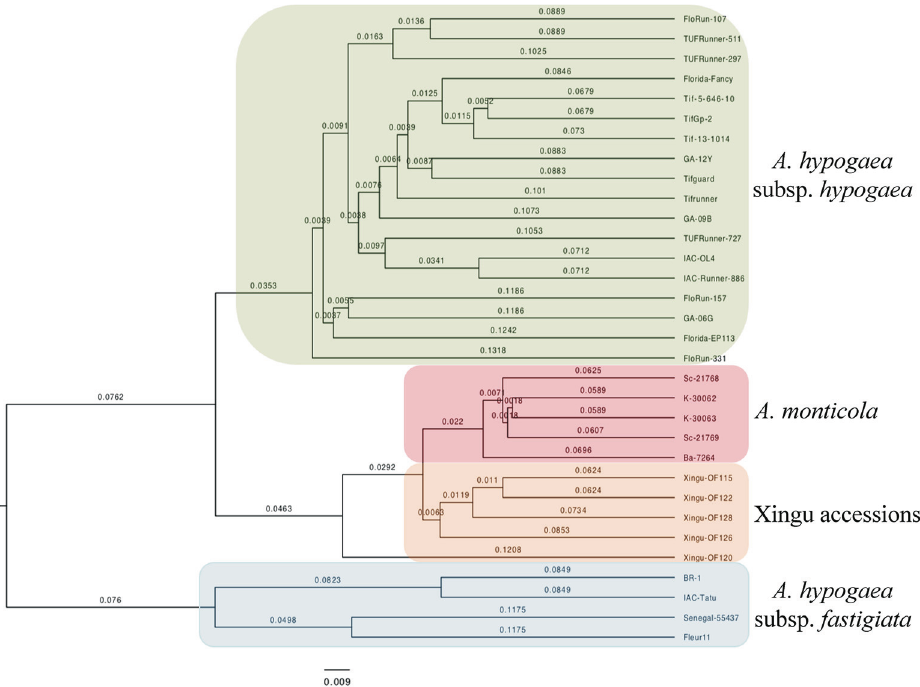
Figure 7 - Dendrogram representing the genetic distance matrix based on SNP data, showing four taxonomic clusters including 22 A. hypogaea , five A. monticola and five Xingu Park